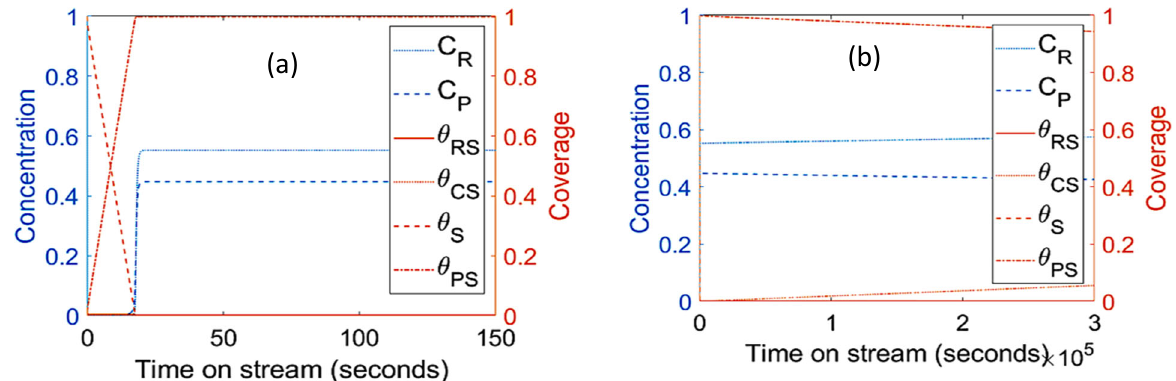
Figure 4. Estimated reactant and product concentration profiles ( left axis ) and surface species coverages ( right axis ) with respect to time for mechanism III at different scales of time on stream: ( a ) Short times on stream up to 150 s. ( b ) Large times on